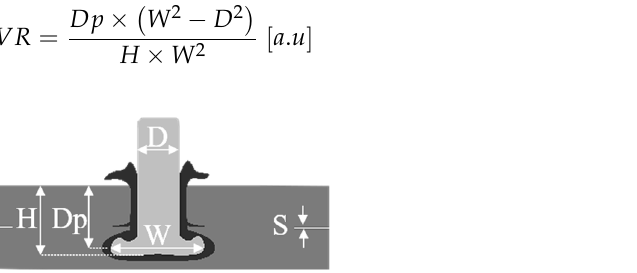
Figure 4. Schematic illustration of a single overlap friction-riveted joint showing geometrical features of the anchoring zone (H, Dp, and W) as well as the separation between the composite parts (S).